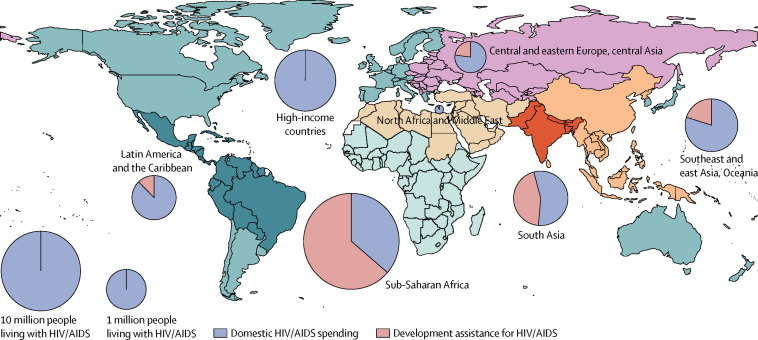
Domestic HIV/AIDS spending, development assistance for HIV/AIDS, and number of people living with HIV/AIDS, 2015The size of each pie represents the number of people living with HIV/AIDS in 2015, in each specified Global Burden of Disease super-region. Domestic spending includes out-of-pocket, government, and prepaid private spending. Number of prevalent cases date to 2015, and are sourced from the Global Burden of Disease Study 2016.21